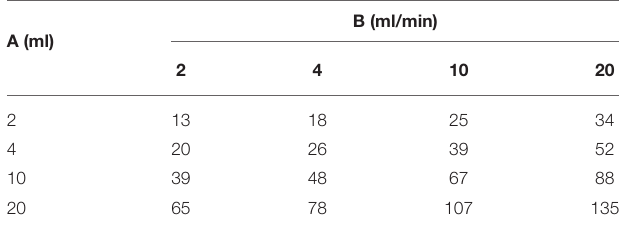
TABLE 3 | Maximal allowable total fluid volume (ml), divided into 15 epidural bolus injections over 30min, for epidural pressures not to exceed 100 mmHg for several values of A and